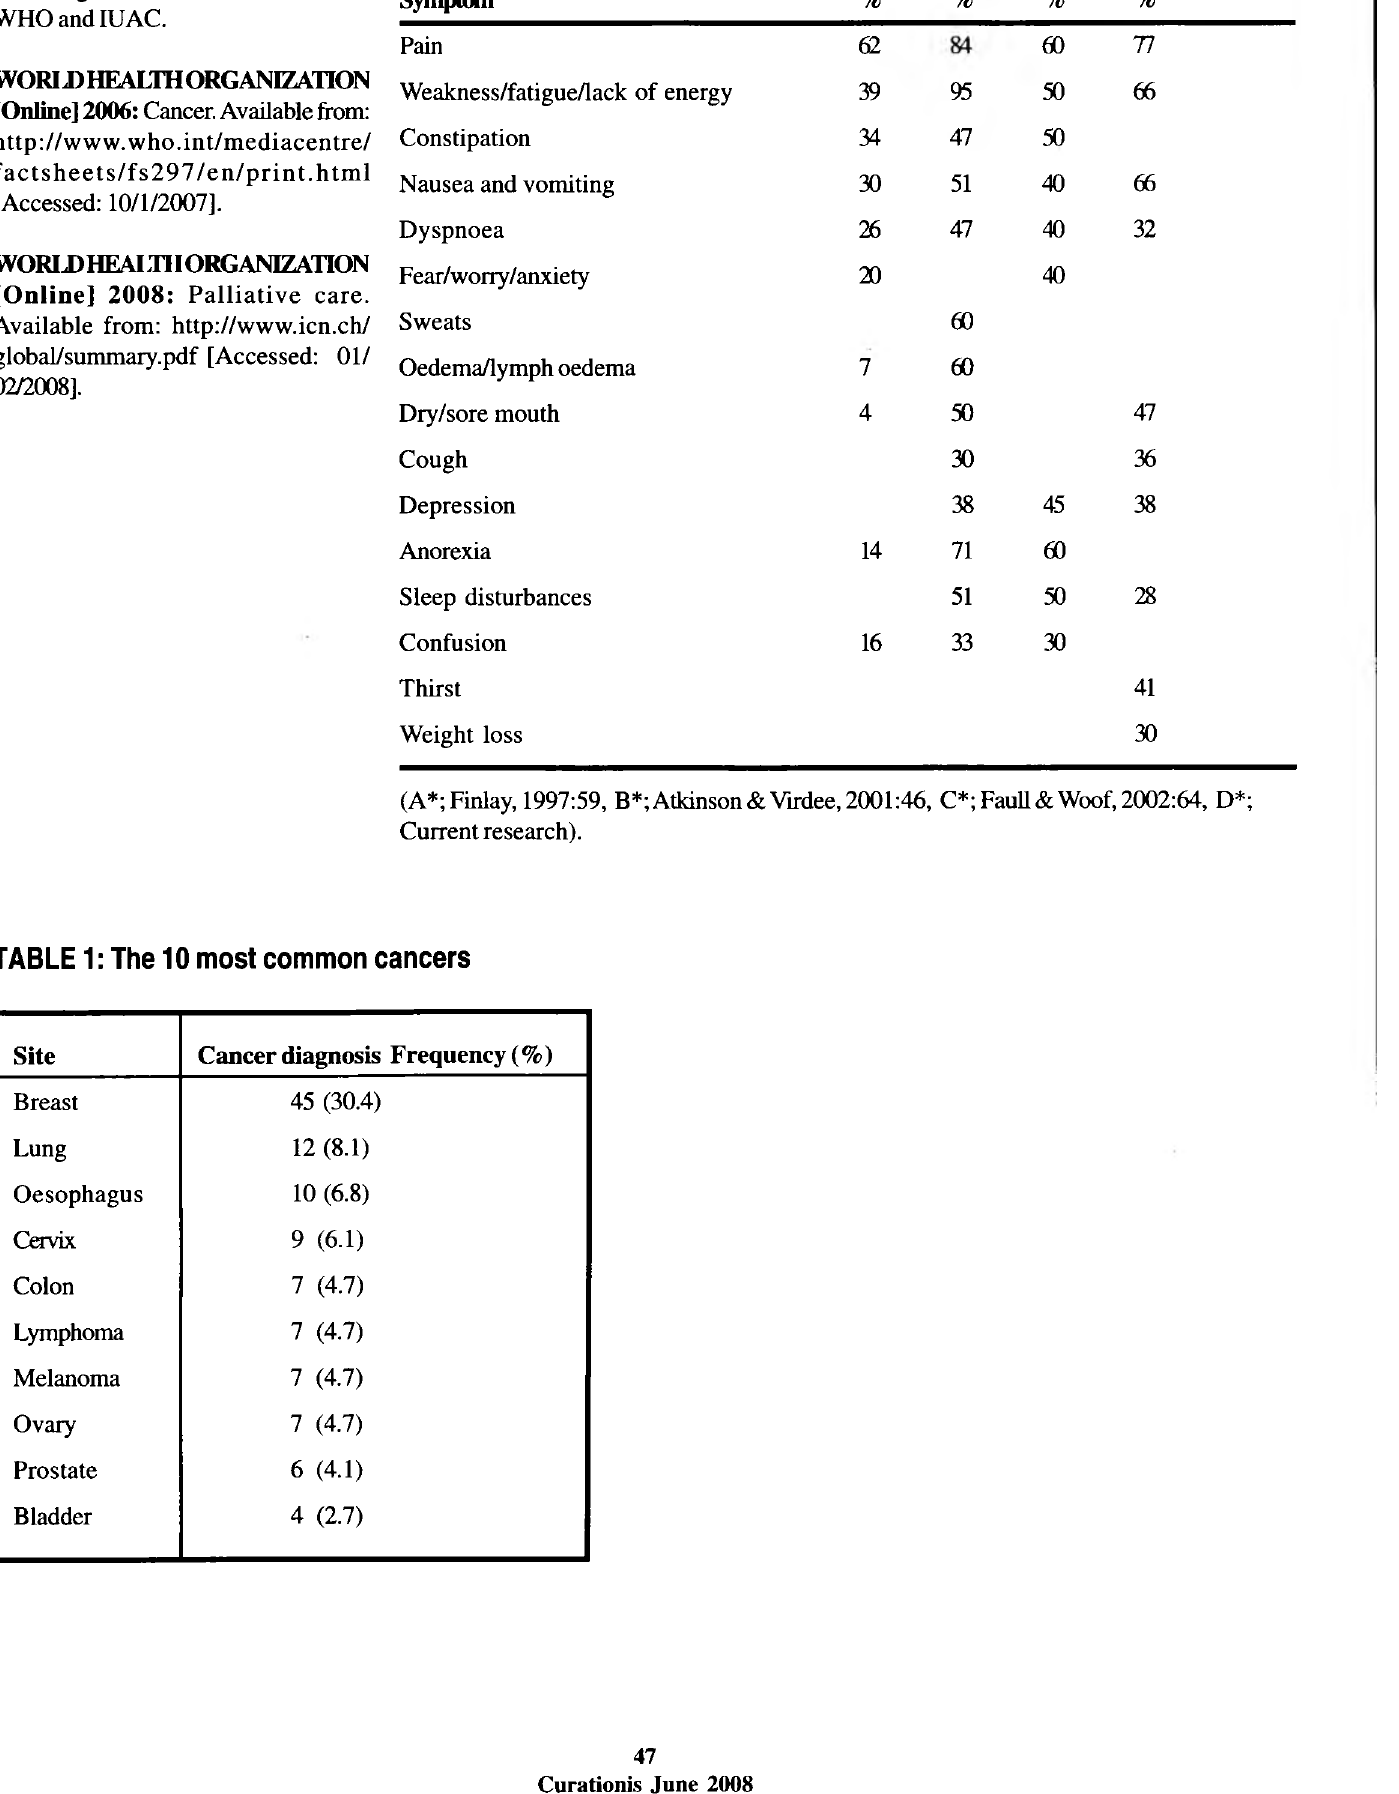
Site Cancer diagnosis Frequency